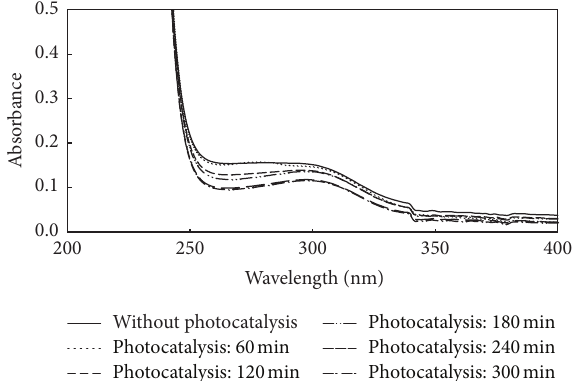
Figure 6: UV spectra of feed water during various irradiation periods for TiO 2 -film photocatalysis (5 coating